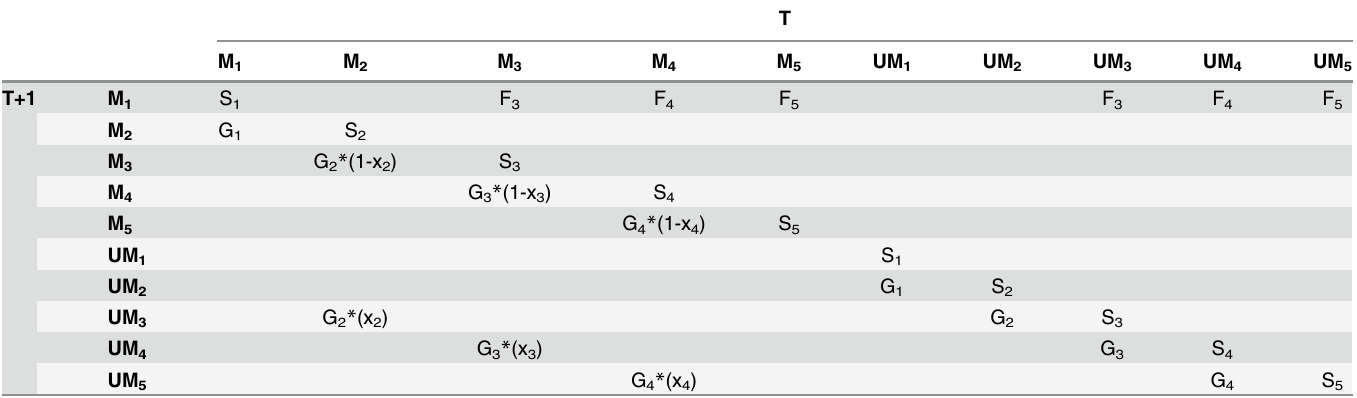
Table 1. Transition matrix model used for management simulations. x- Probability that merchantable (M) trees growing to next size class will become unmerchantable (UM) because of defects. S = survival probability, G = size class upgrowth probability, F = Fertility rate per capita; Number of DBH size clas- ses (denoted by subscripts) are reduced for better visualization as size classes are 2.5 cm wide, except for first size class (5 – 9.9 cm